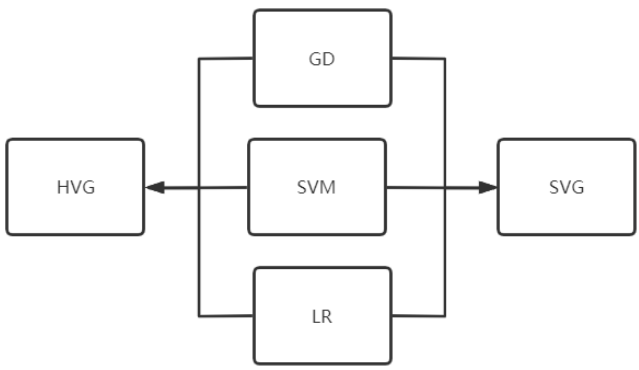
Figure 3. Generating hard voting HVG and soft voting SVG.